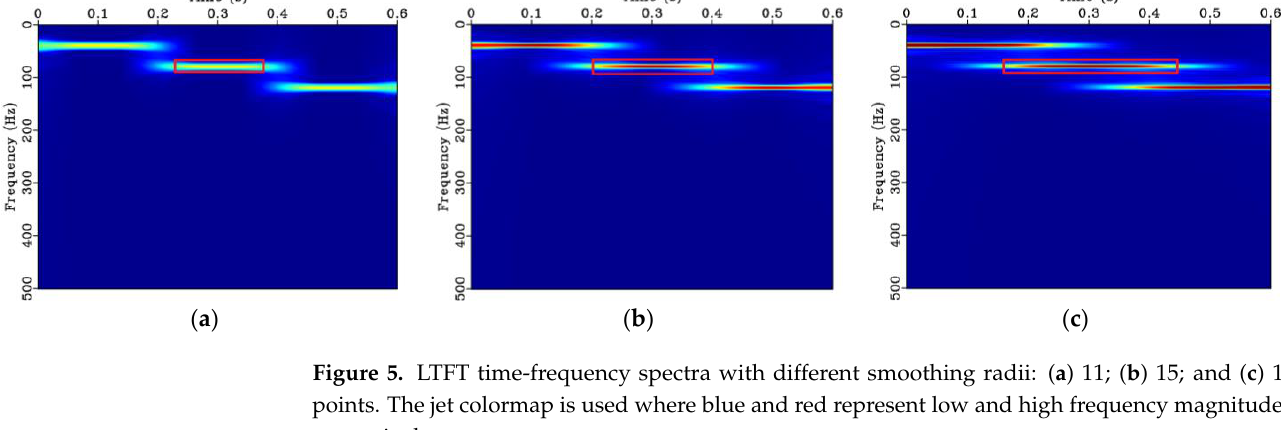
Figure 4. STFT time-frequency spectra with different time window lengths: ( a ) 13; ( b ) 21; and ( c ) 29 points. The jet colormap is used where blue and red represent low and high frequency magni- tudes, respectively.